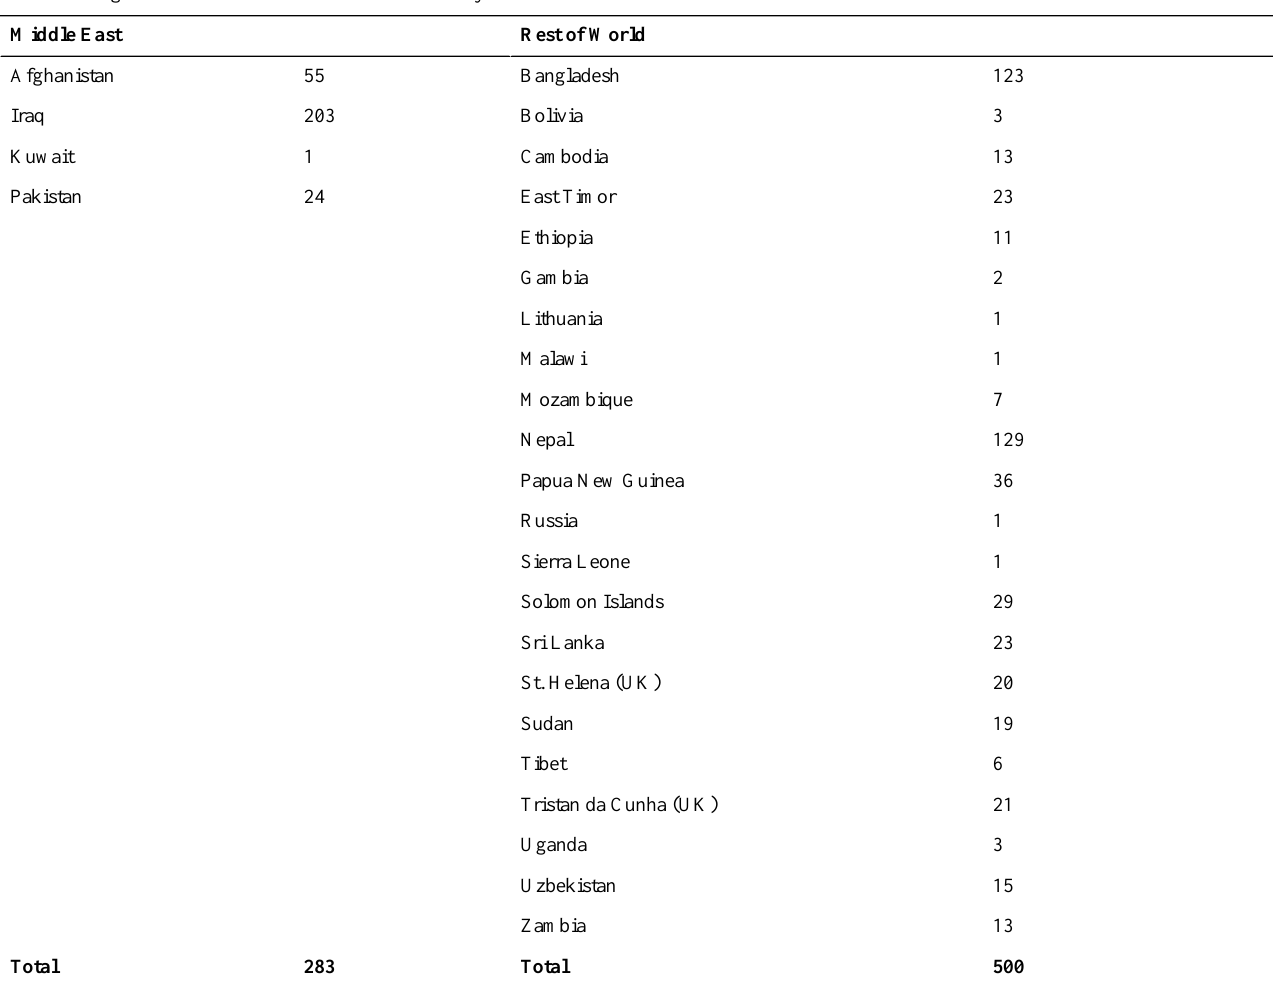
Table 1. Origin and numbers of cases referred from July 2004 to June 2007